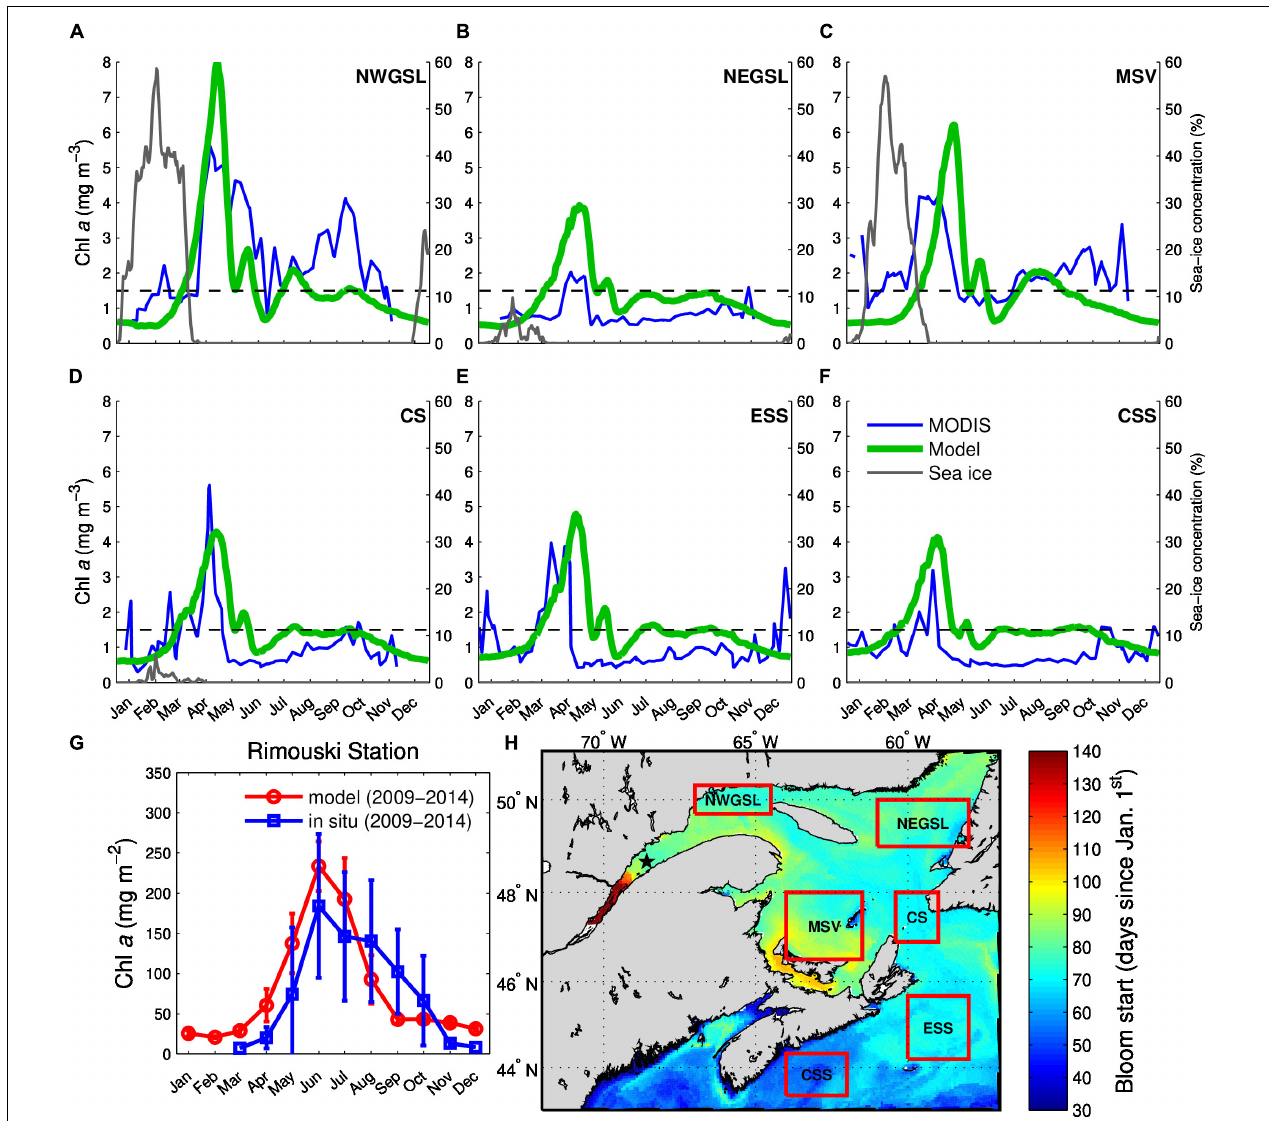
FIGURE 8 | Mean surface chlorophyll a (mg chl a m − 3 ), simulated (green) and from satellite-derived data (MODIS, blue) over specific regions (panels A–F , see red boxes on the map in H ) for the 2011 to 2013 period. The dotted line depicts the 1.45 mg chl a m − 3 threshold used to calculate the beginning of the bloom. The latter is shown in panel (H) (number of days from January 1st). The weekly mean chlorophyll a satellite data were obtained from the Bedford Institute of Ocean Sciences. Following Head and Pepin (2010), the mean values obtained with a box area coverage smaller than 10% were discarded. The gray line in panels (A–D) represent the average sea-ice concentration in the boxes. Panel (G) displays the 0–100 m integrated chl a (mg m − 2 ) at the AZMP Rimouski station in the Lower St. Lawrence Estuary (star on map in H ) simulated (red) and measured in situ (blue) averaged over the 2009 to 2014